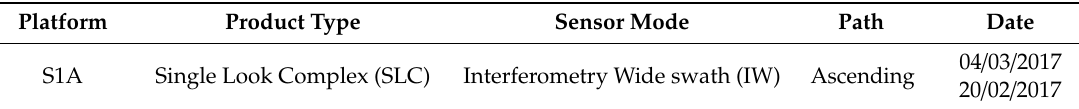
Table 2. Technical characteristics of images used in this study.